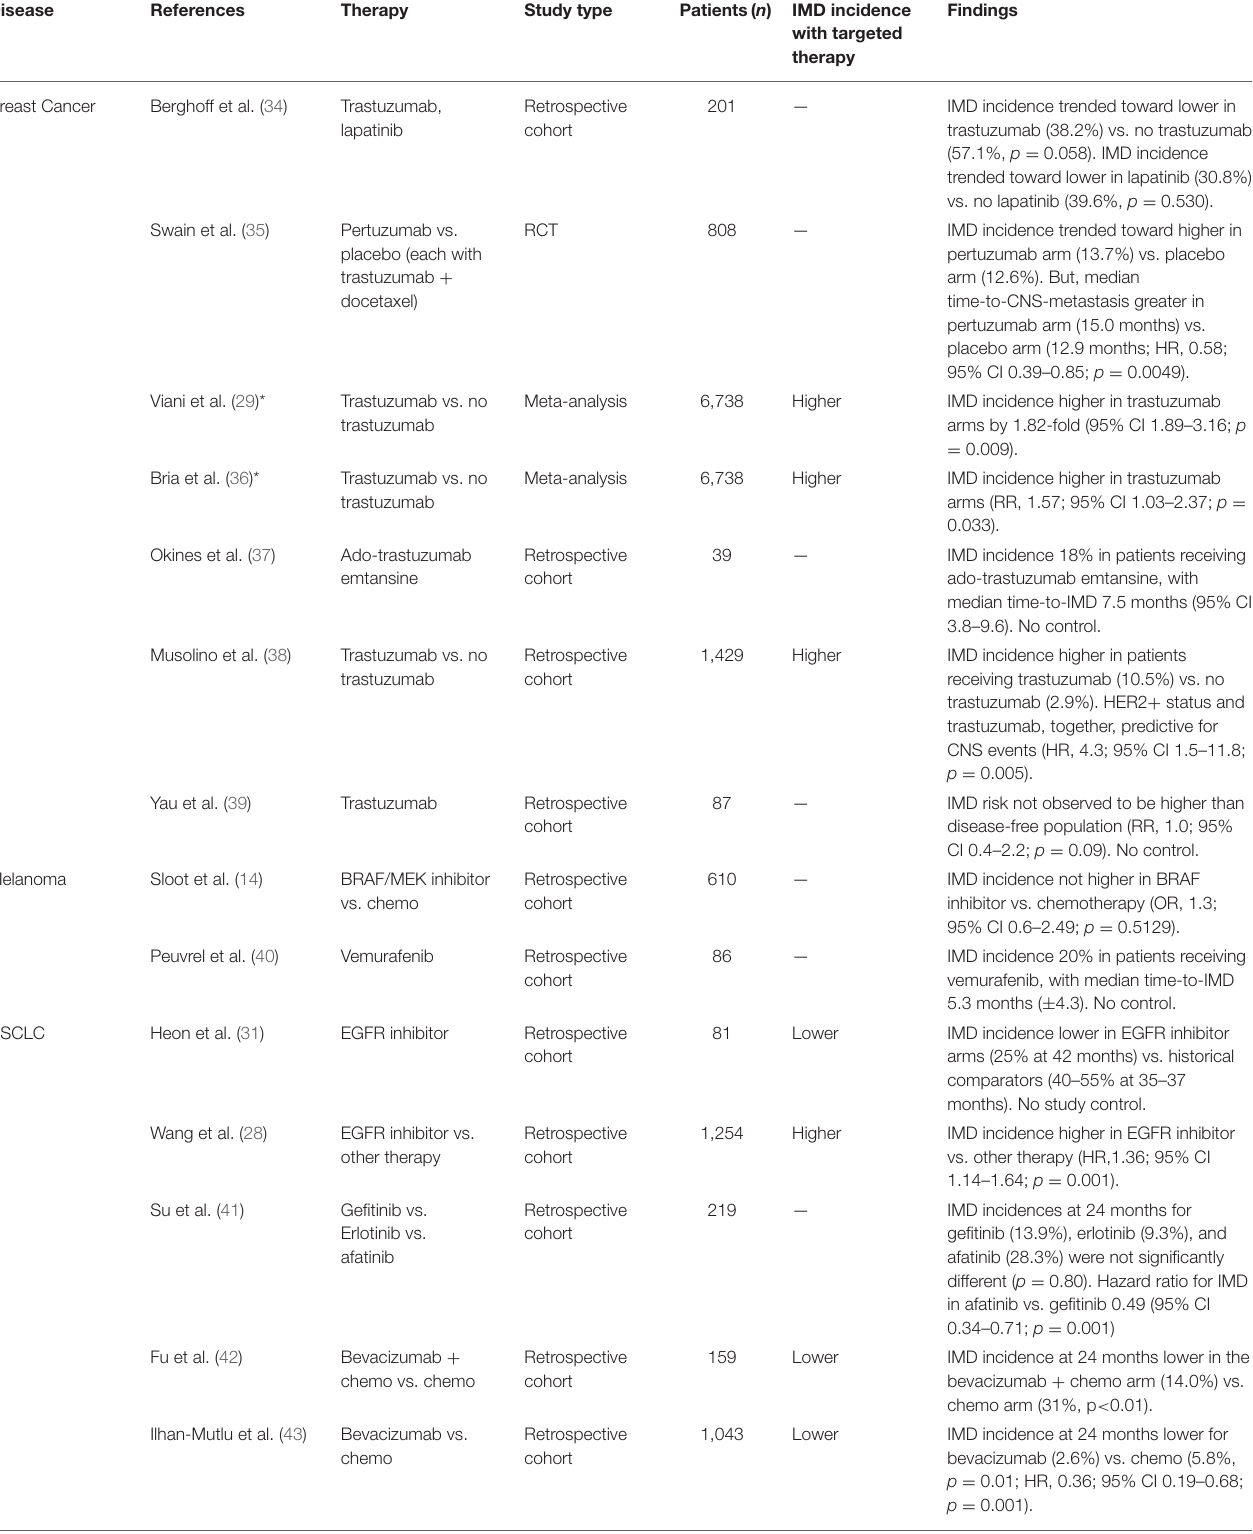
TABLE 1 | Select studies reporting on IMD incidence in patients receiving targeted therapy.